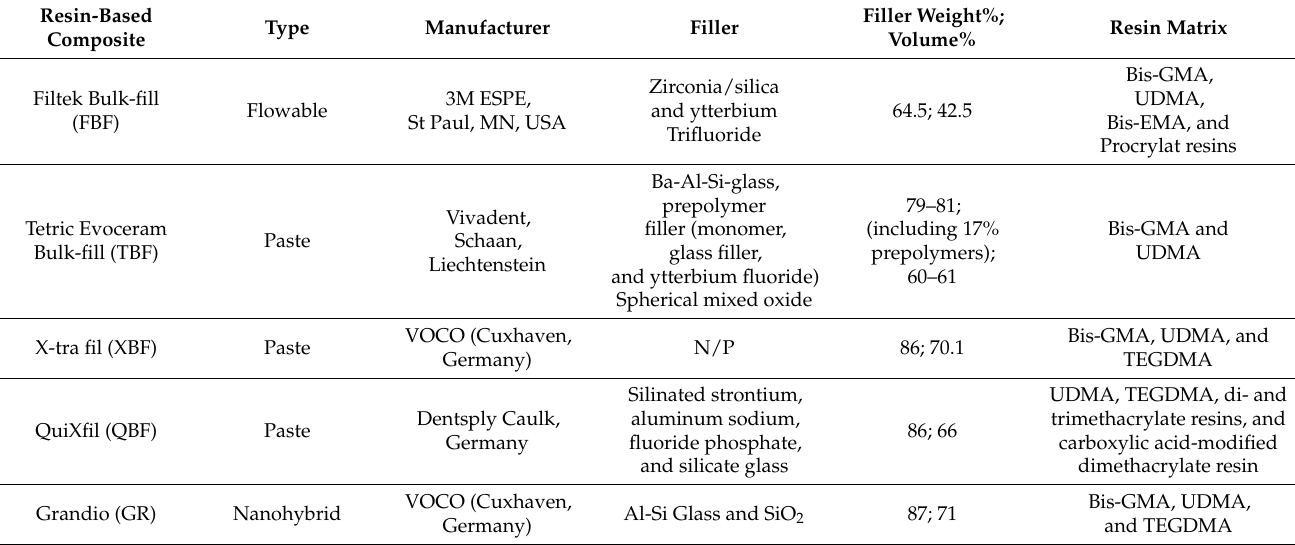
Table 1. The composition of resin-based composites evaluated in the current